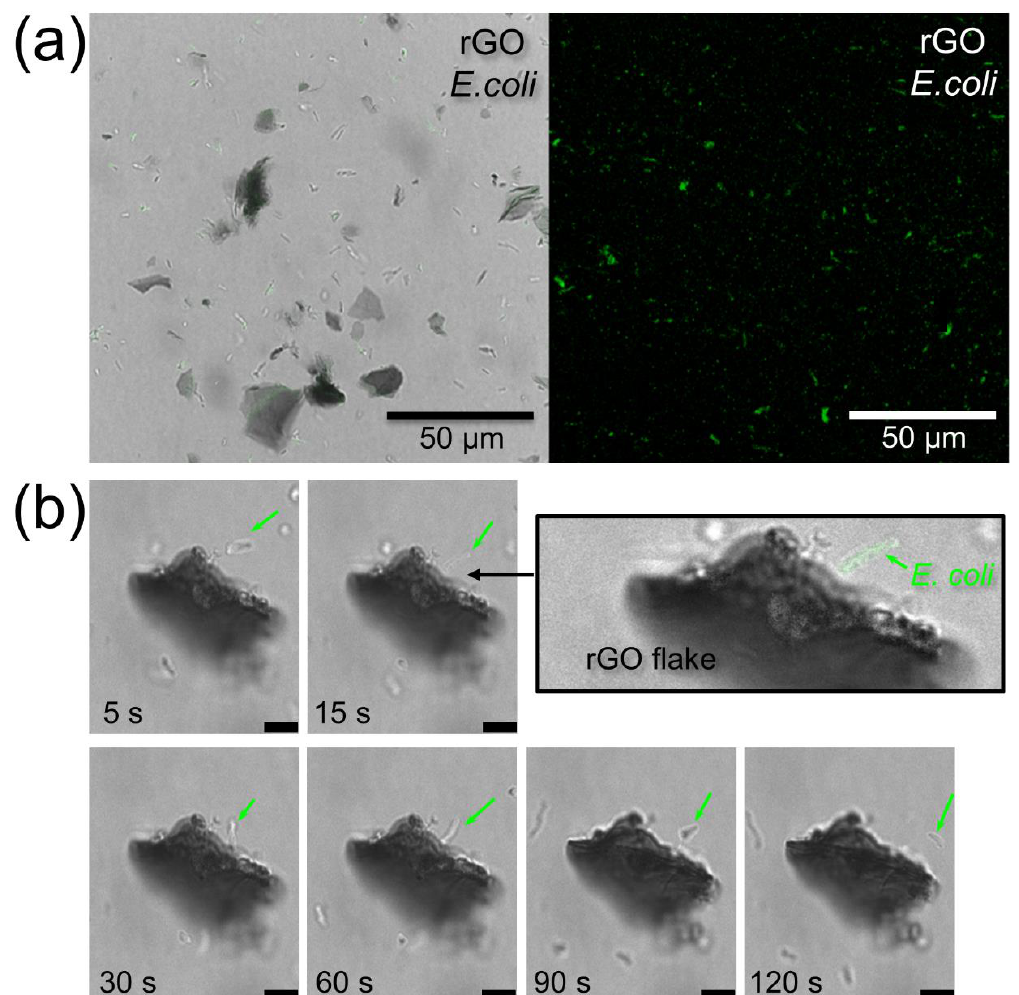
Figure 4. Dynamics of the interaction of rGO and bacteria dispersed in PS. (a) Optical (left) and confocal (right) images of rGO flakes (10 mg/L) and E. coli bacteria dispersed in a droplet of PS. Live bacteria emit a green fluorescent signal. (b) A series of confocal microscopy images illustrating the interaction of an individual E. coli shown by the green arrows with a rGO flake. Scale bars are 5 μm.